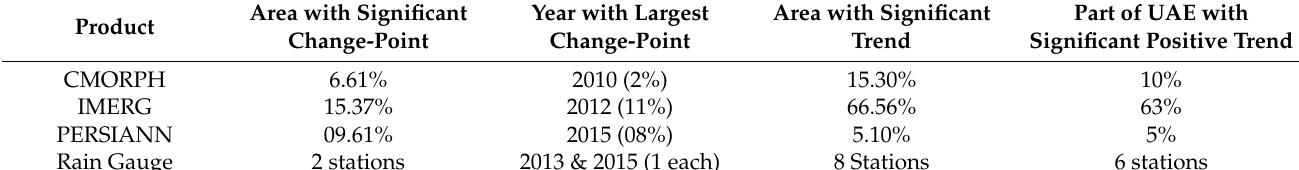
Table 3. The fraction of the area that experiences a significant change-point (Pettitt’s test), a significant trend (Correlated Seasonal Mann–Kendall test), and the years with the largest change point for the different precipitation products.